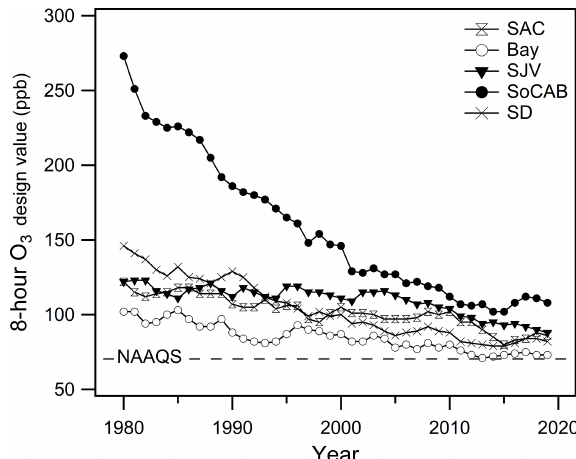
Figure 1. The 8h O 3 design value in five air basins in California from 1980 to 2019. The dash line is the 2015 8h O 3 NAAQS ( = 70ppb). The five air basins include the Sacramento Valley (SAC), San Francisco Bay Area (Bay), San Joaquin Valley (SJV), South Coast Air Basin (SoCAB), and San Diego County (SD). Data col- lected from the California Air Resources Board